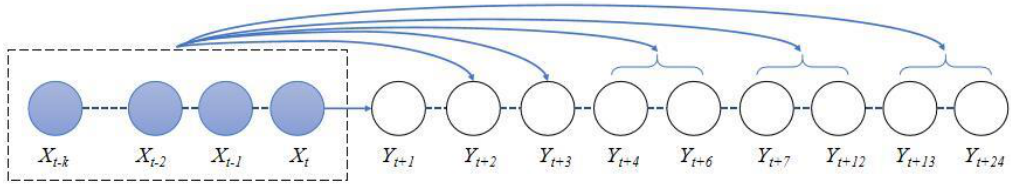
Figure 2. Illustration of the multiscale predictors.